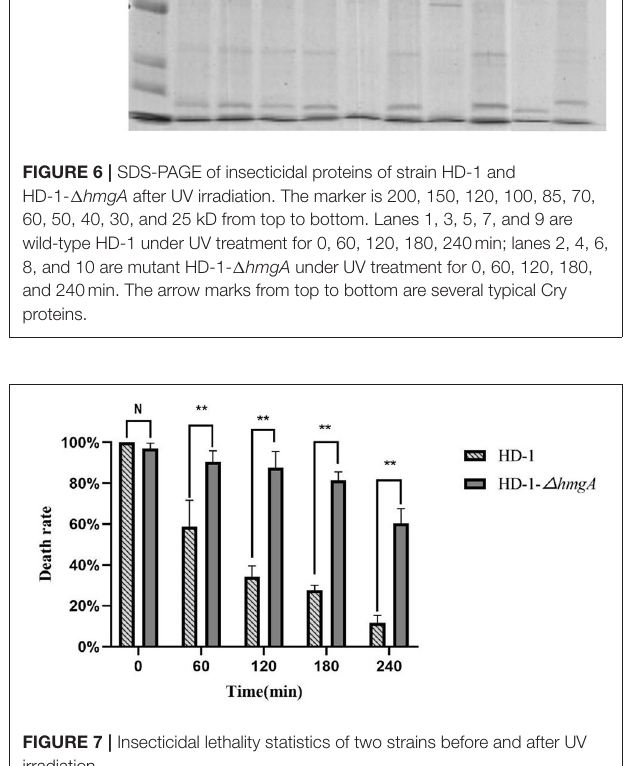
Spore-crystal preparations of strain HD-1 and HD-1- 1 hmgA were irradiated by UV light under different time intervals.